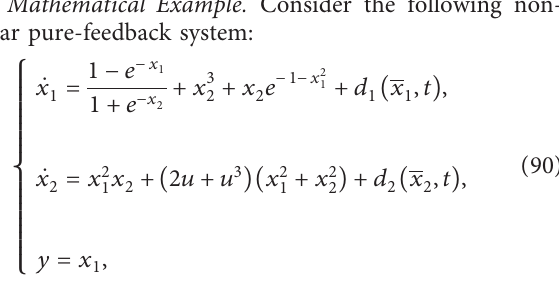
Figure 5: Tracking error y − y